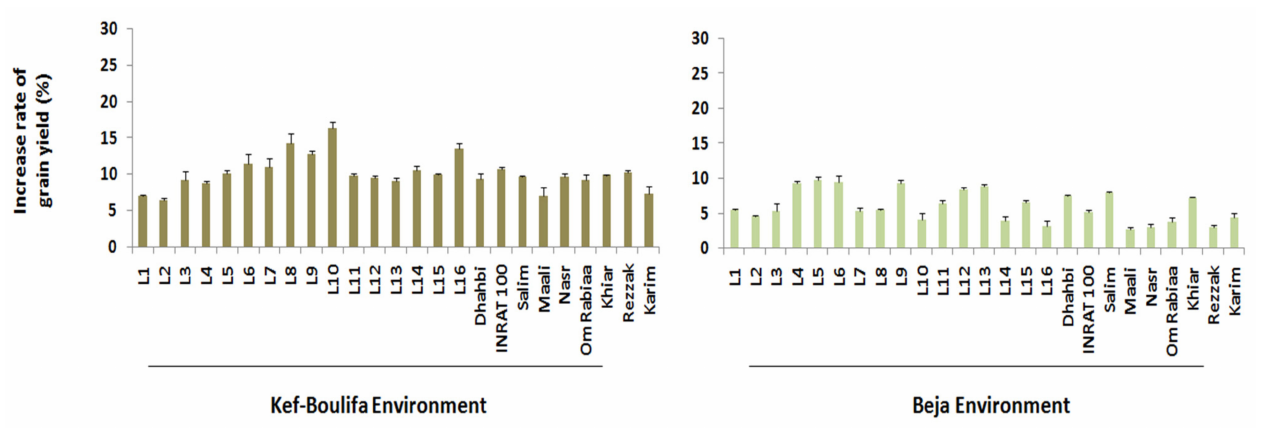
Figure 1. Increase rate of grain yield of 25 durum wheat cultivars after Se foliar supply across the two